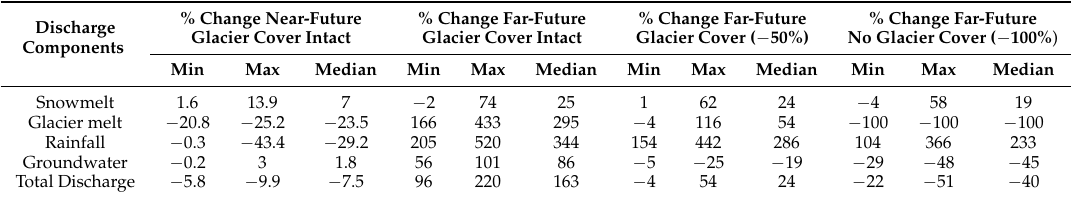
Table 7. Percentage Change in the future water availability under near- (2013–2030) and far-future (2087–2097) climate change